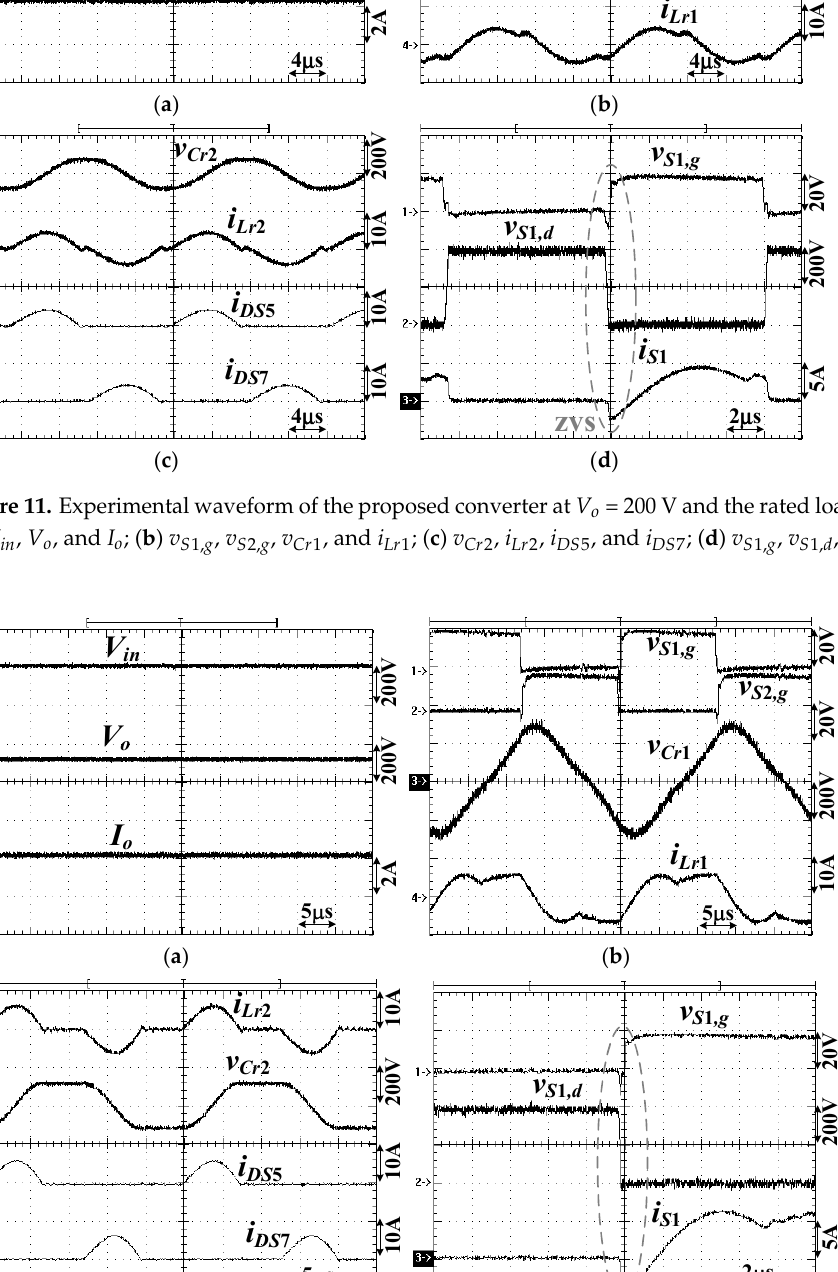
Figure 12. Experimental waveform of the proposed converter at V o = 310 V and the rated load current ( a ) V in , V o , and I o ; ( b ) v S 1, g , v S 2, g , v Cr 1 , and i Lr 1 ; ( c ) i Lr 2 , v Cr 2 , i DS 5 , and i DS 7 ; ( d ) v S 1, g , v S 1, d , and i S 1 .